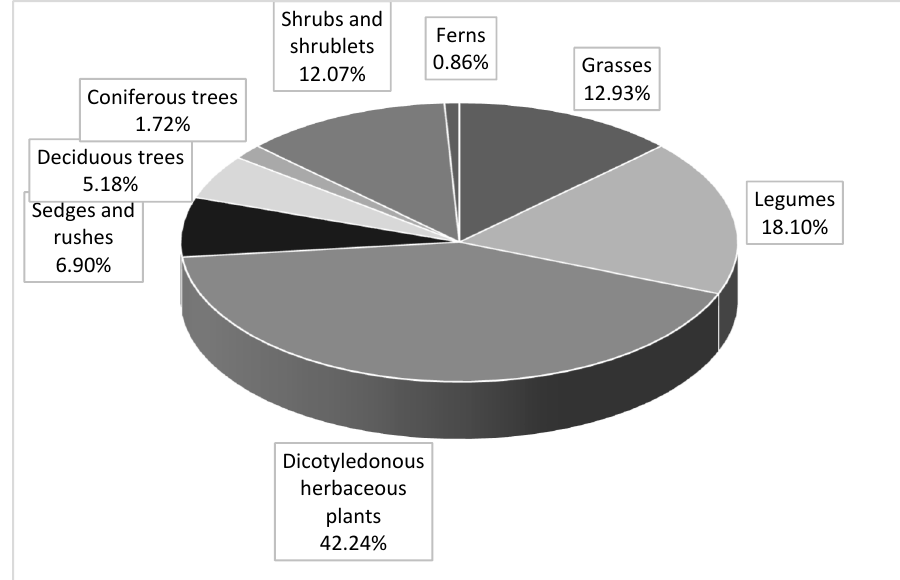
Figure 1. Structure of plant groups in the organic feeding grounds.